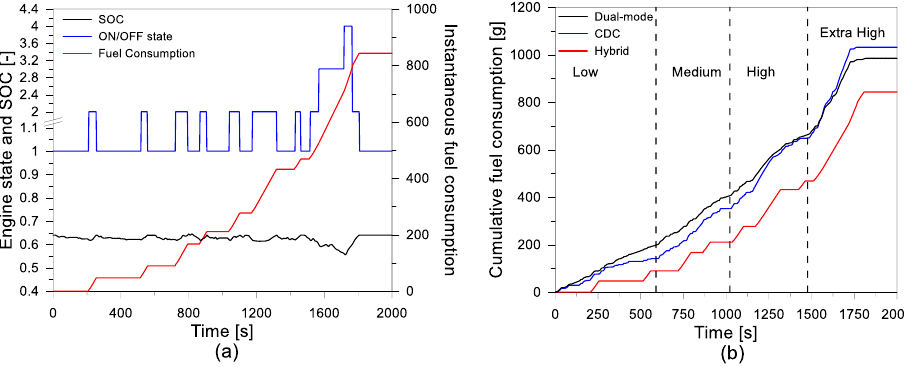
Figure 15. SOC, internal combustion engine (ICE) on-off state, and cumulative fuel consumption for the hybrid powertrain ( a ) and instantaneous fuel consumption comparison for the different concepts ( b ) during the WLTC cycle.